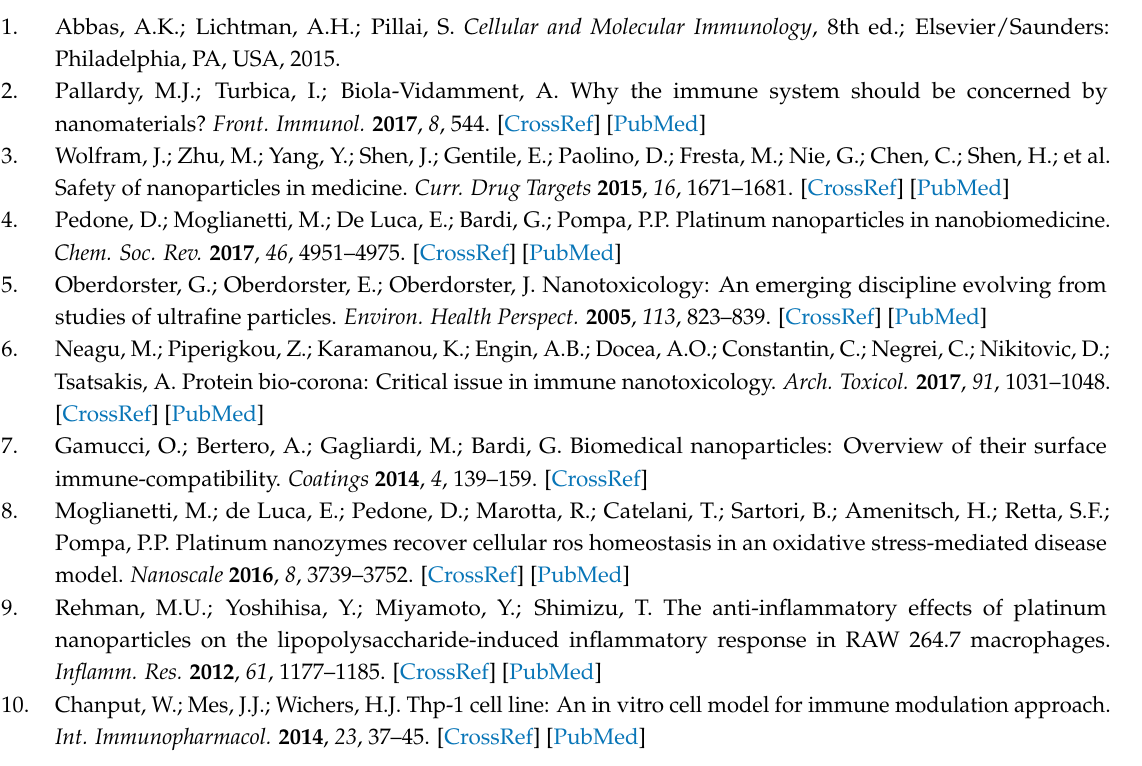
Figure S1: WST-8 assay of HeLa cells treated with increasing concentration of PtNPs for 24 h, Figure S2: Flow cytometer dot plots and TEM images of internalized undifferentiated and differentiated HL60, Figure S3: Dot plots show the comparison between untreated and PtNP-treated differentiated HL60 for 24